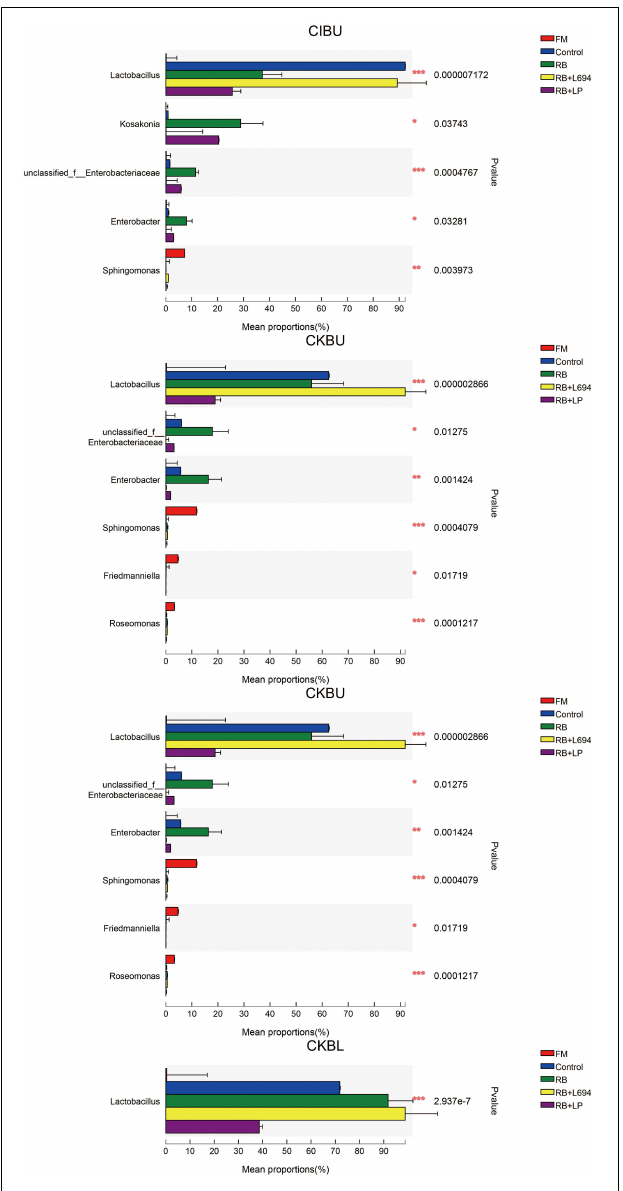
FIGURE 6 | Mean proportions between bacterial communities and relative abundance of Caragana materials and their silages at phylum level and genus level ( n =